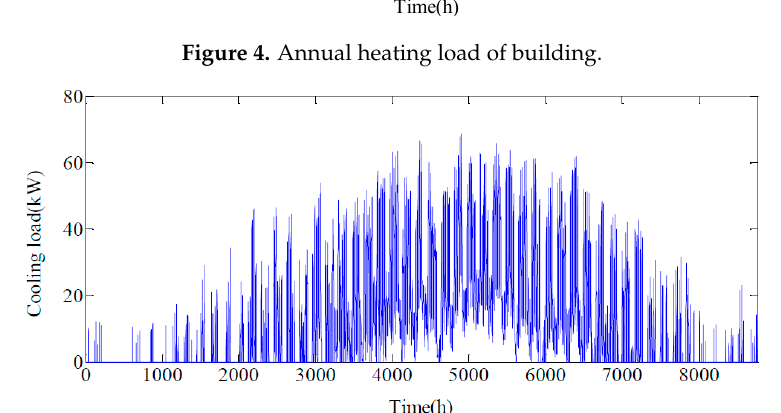
Figure 5. Annual cooling load of building.